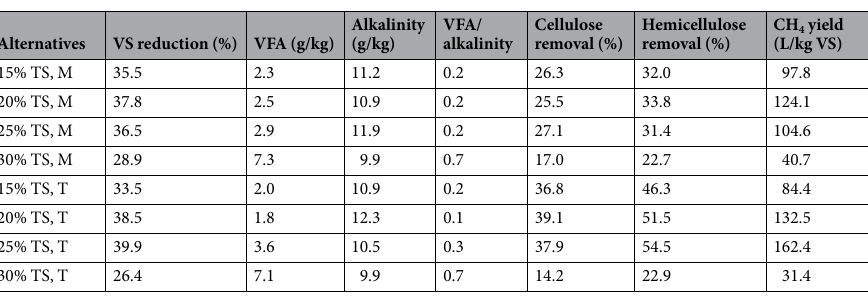
Table 5. Decision matrix as per experimental results of SSAD of